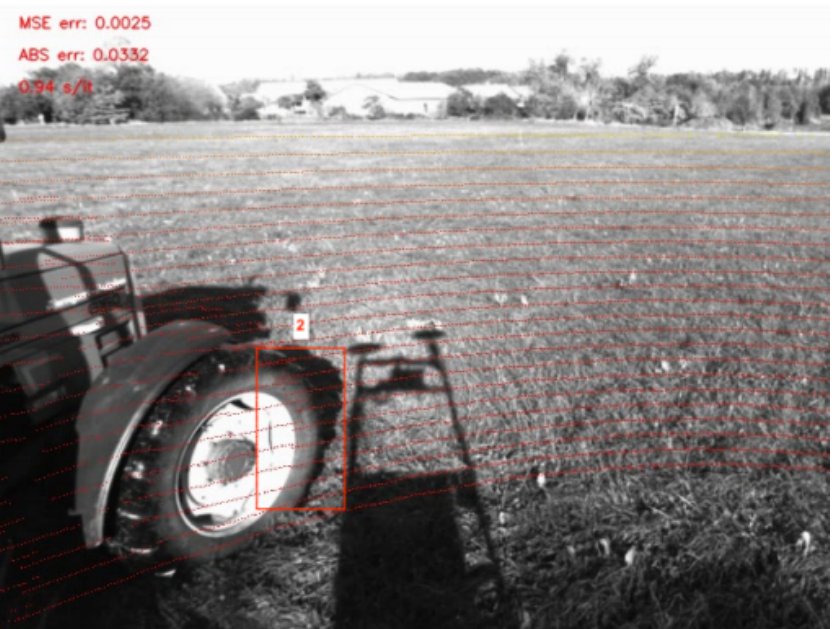
Figure 6. Example of LiDAR reprojected on the image. Note that a small error in the calibration will result in strong error on the estimated depth (see Square 2). We processed the error w.r.t. the depth obtained by